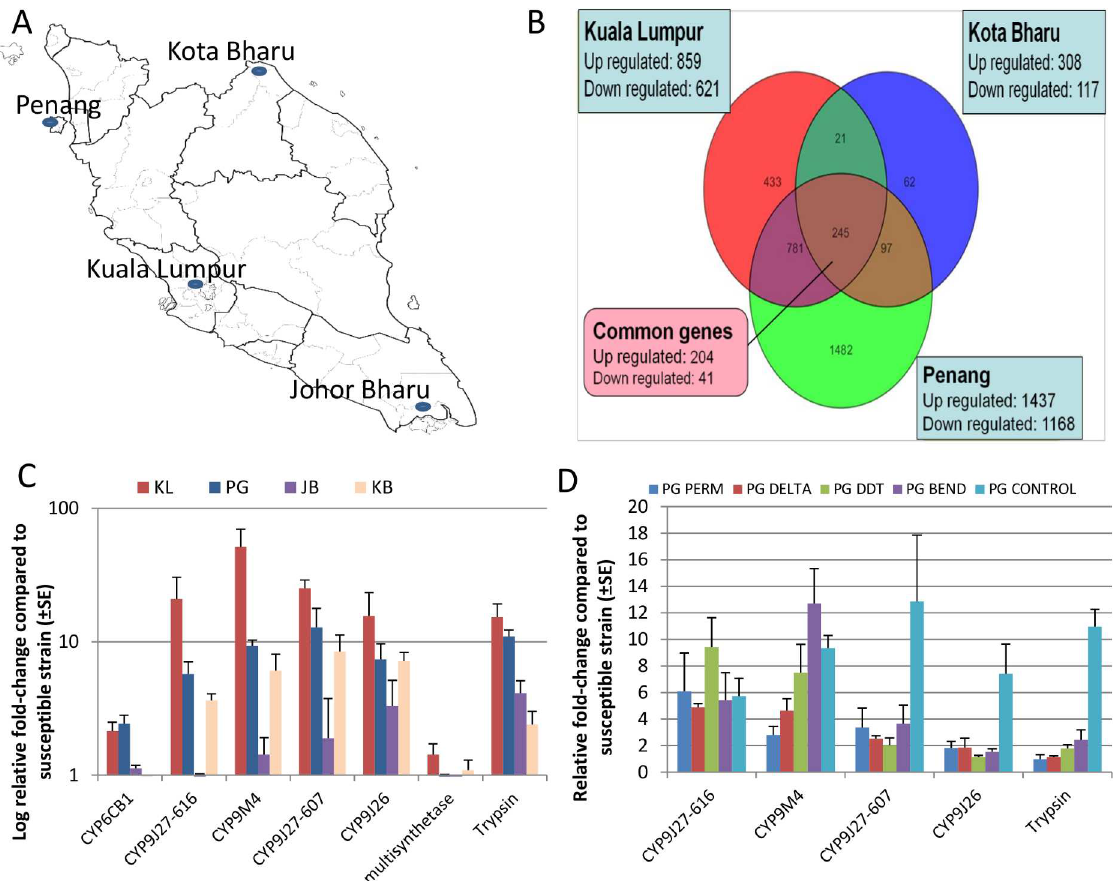
Fig 1. Transcription profiling of Ae . aegypti in Malaysia. A) Map of the Malaysian peninsular showing the four collection sites of Penang (PG), Kota Bharu (KB), Kuala Lumpur (KL) and Johor Bharu (JB). B) Venn diagram of differentially transcribed genesfrom microarray data (p = 0.01); C) Relativefold-changeof candidategenesfrom qRT-PCRanalysis;D) Relativefold-change of candidategenesfrom qRT-PCR analysisfor resistant samplesfrom Penang. Perm stands for Permethrin,Delta for deltamethrin, Bend for